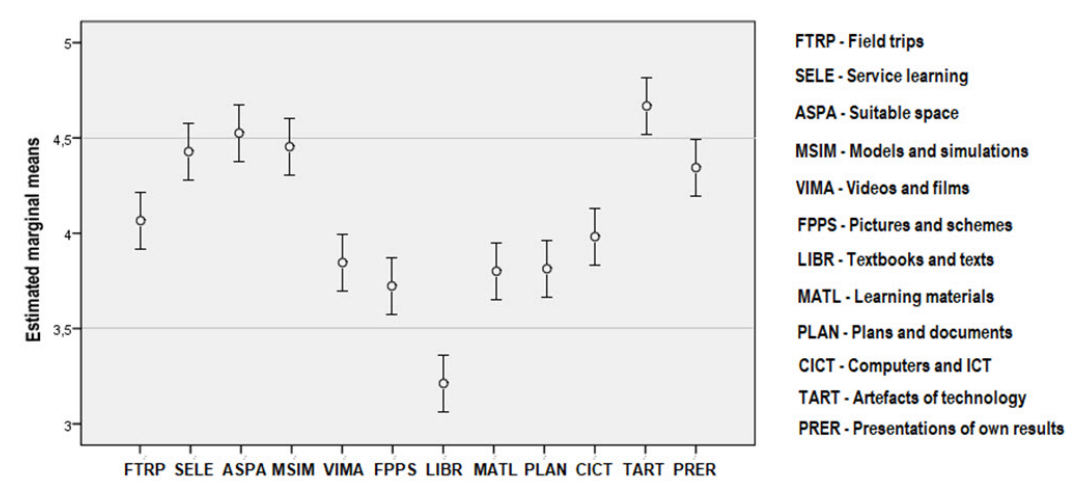
Figure 3. Estimates of the influence of contextual elements on pupils’ application of